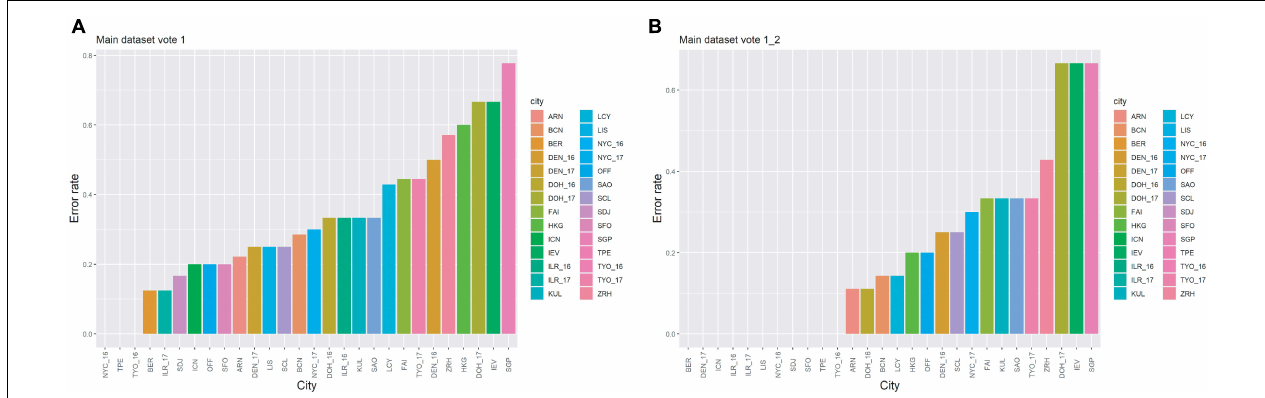
FIGURE 3 | The error rates for the cities in the main dataset. (A) The results are based on the highest vote. (B) The results are based on the highest and the second-highest votes. TABLE 4 | The average predicted level for non-microbial features for new cities in the mystery dataset. City Summer temperature Winter temperature Summer humidity Winter humidity Coastal indicator Degree of